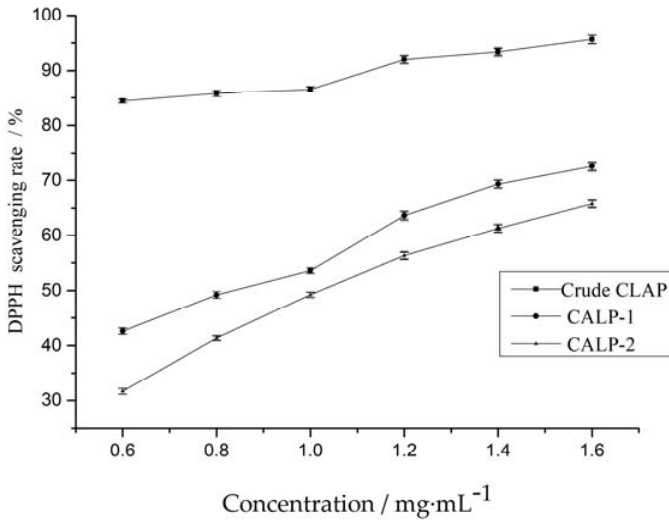
Figure 11. Scavenging activities of Choerospondias axillaris leaf polysaccharide on DPPH .